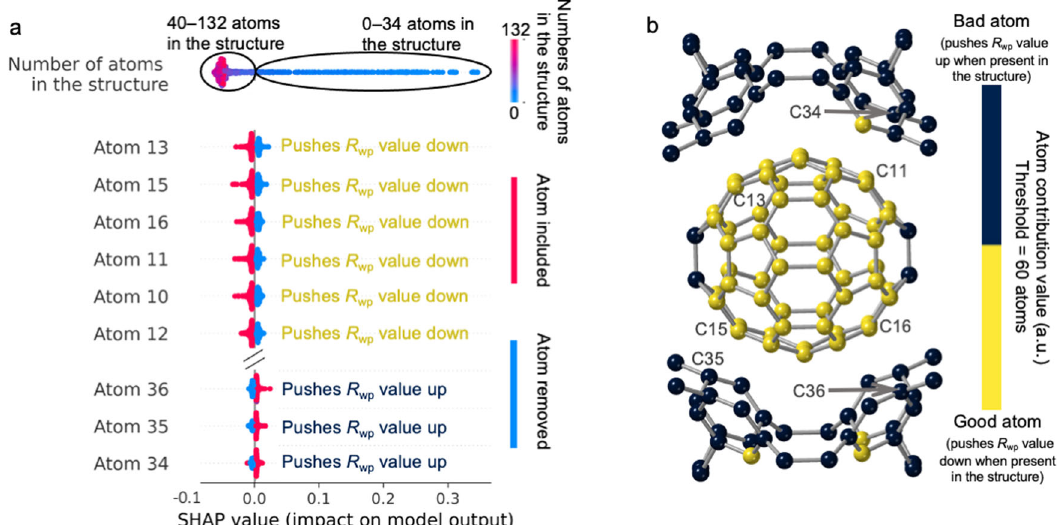
Fig. 5 Summary of the ML-MotEx analysis of C 60 PDF. a Plot of the SHAP values obtained in the C 60 analysis, showing if atoms in the starting model are favourable for the fi t quality. For the models where the atom is not present in the model, the SHAP value is shown in blue, while it is shown in red for the atoms where it is present in the model. The SHAP values are plotted as a violin plot. An enlarged summary SHAP plot of panel a is shown in Supplementary Fig. 14. b Structural visualization of kept and removed atoms. The atoms with the 60 lowest atoms contribution values have been coloured yellow, while the rest are coloured black. Supplementary Figure 1 shows a similar representation but where the atom contribution values are directly shown from a continuous colour